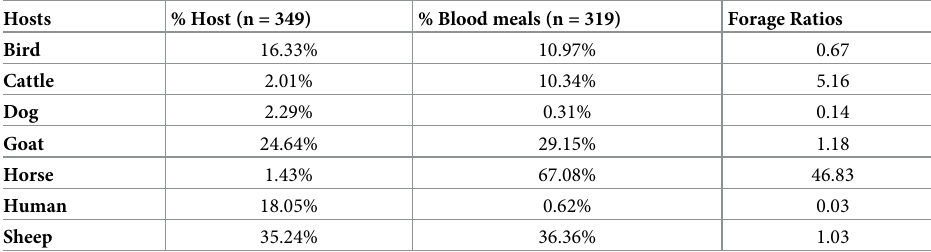
Table 3. Aedes v . arabiensis forage ratios for domestic animals, human and bird in all study